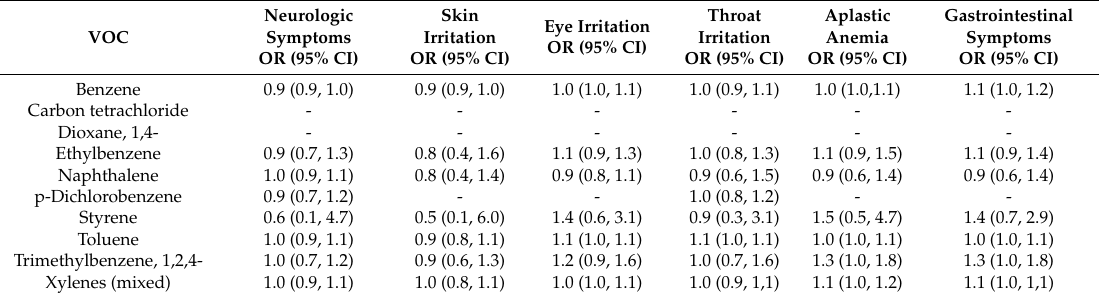
Table 3. Univariate Logistic Regression Estimates for the Association between Select Indoor VOCs and Self-Reported Health Symptoms.